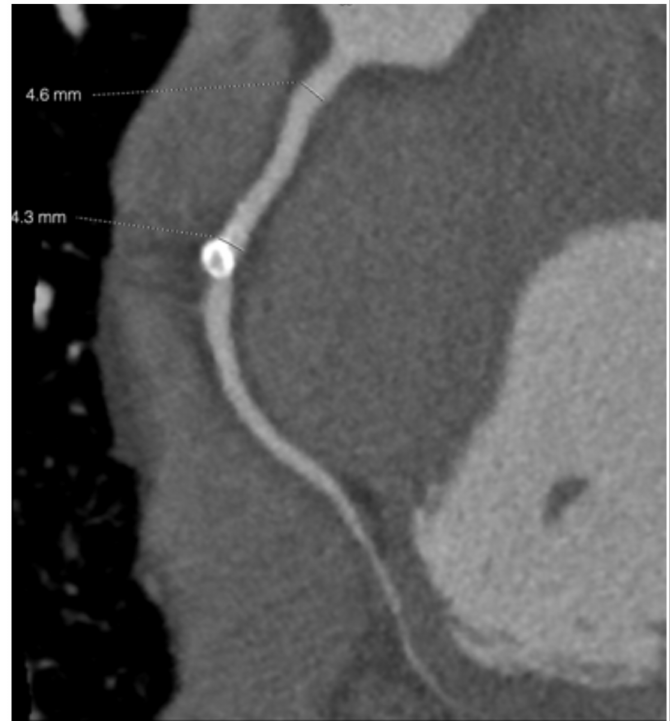
Figure 3. CT angiogram of right coronary artery with dense calcification of its mid